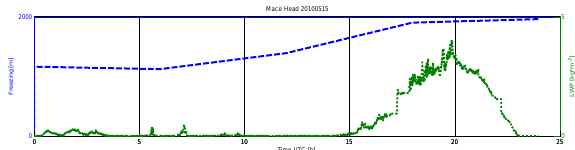
Figure 1: Time evolution of liquid water path (in kg/m 2 ), de- rived from HATPRO microwave radiometer, and freezing level during May 15, 2010. Figure 3: (Upper panel) Classification of ash cloud observed at Mace Head May 15 2010, from 20:00 to 24:00 UTC, using only the radar observables (Z hh and L dr ). (Lower panel) Same as up- per panel, but using both radar and lidar observables (Z hh  L dr ,  hh,  hh ), when available. Note lidar-ceilometer data are not available above 8000